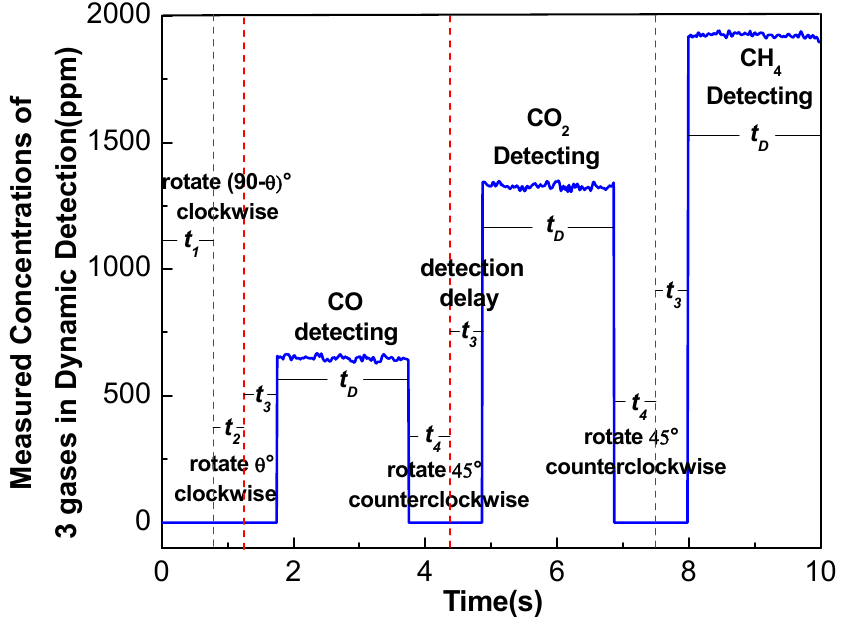
Figure 8. The detection of three gas species, CO, CO 2 and CH 4 within a period of T based on the multi-gas sensor system.